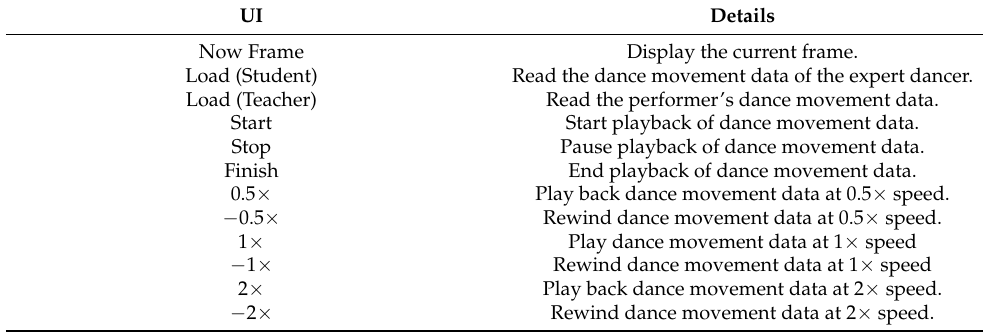
Table 2. Details of each UI in visualization